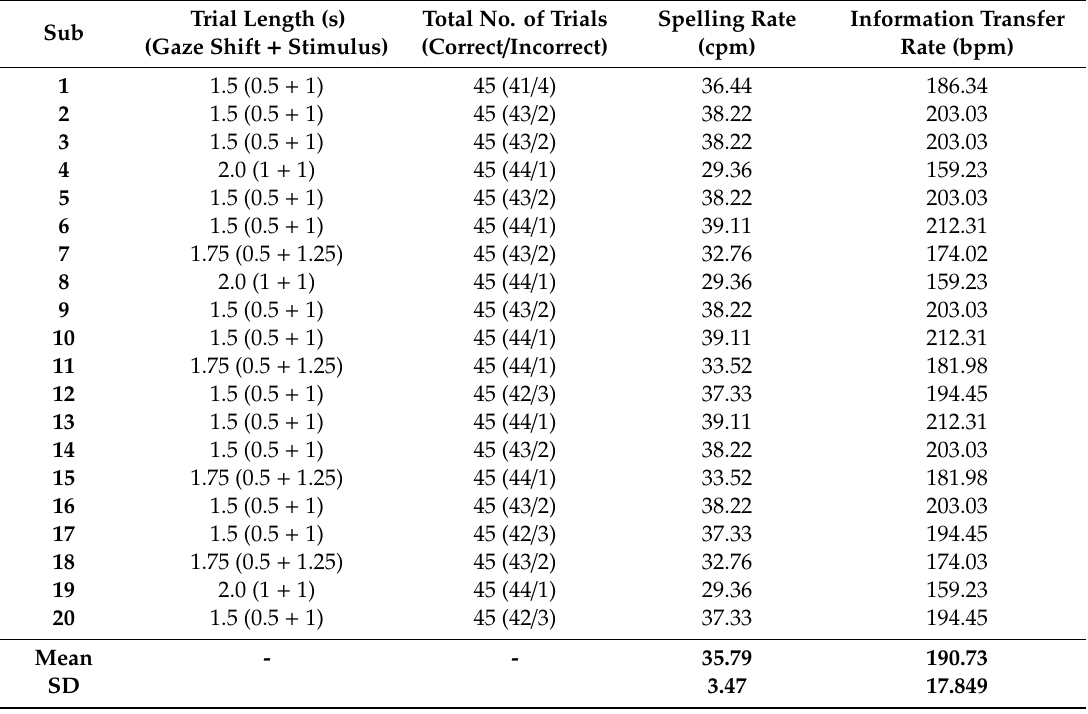
Table 4. Classification accuracy and information transfer rate for the online free-spelling